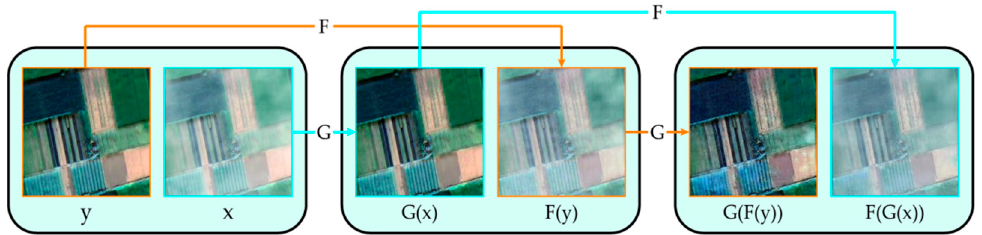
Figure 1. The processing procedure of edge-sharpening cycle-consistent adversarial network (ES- CCGAN).